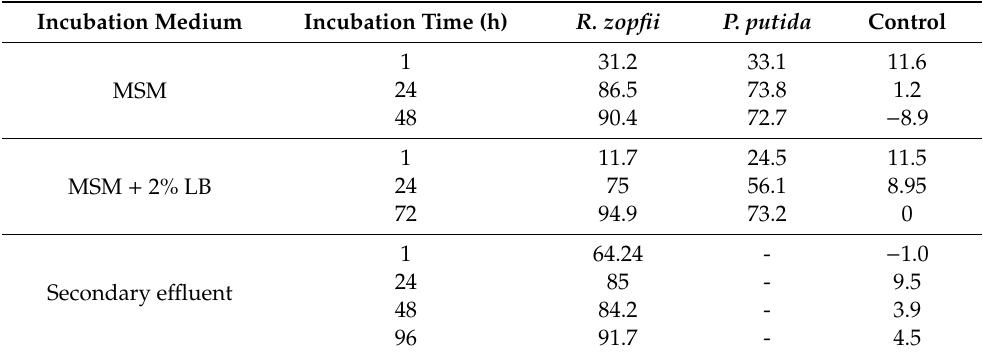
Table 4. EE2 reduction (%) over time by the encapsulated R. zopfii and P. putida in the three experimental media (MSM, MSM + 2% LB, secondary e ffl